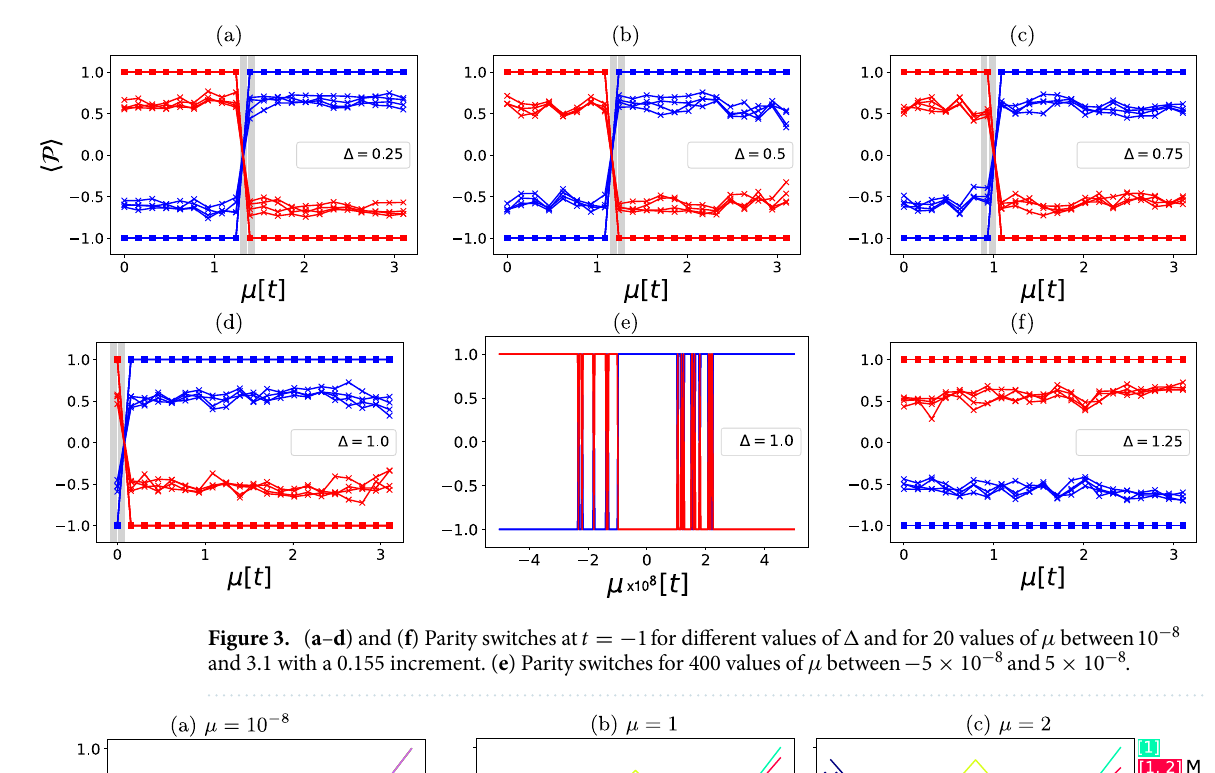
Figure 3. ( a – d ) and ( f ) Parity switches at t = − 1 for different values of (cid:31) and for 20 values of µ between 10 − and 3.1 with a 0.155 increment. ( e ) Parity switches for 400 values of µ between − 5 × 10 −